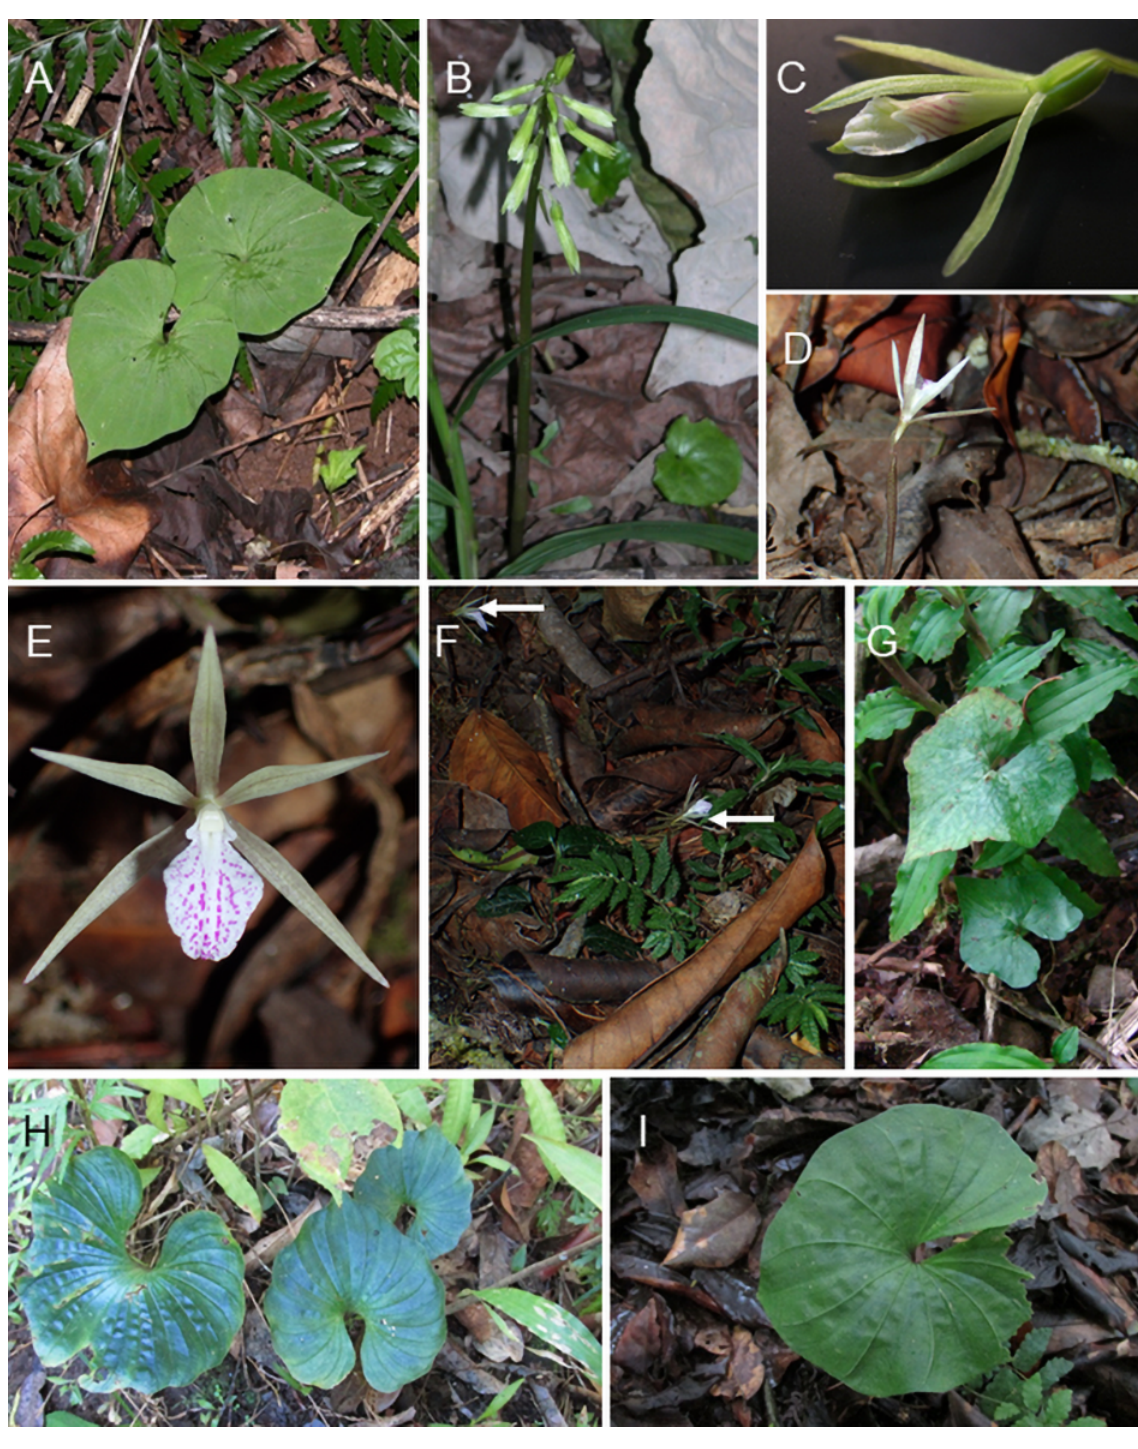
Figure 2 Species of the genus Nervilia found in Bali. ( A – C ) N. aragoana ; ( D–G ) N. punctata ; ( H ) Nervilia sp. 1; ( I ) Nervilia sp. 2. Photo credits: Hanna Margońska ( A–C,G ); Monika Lipińska ( D–F ); Aninda Wibowo ( H–I ).